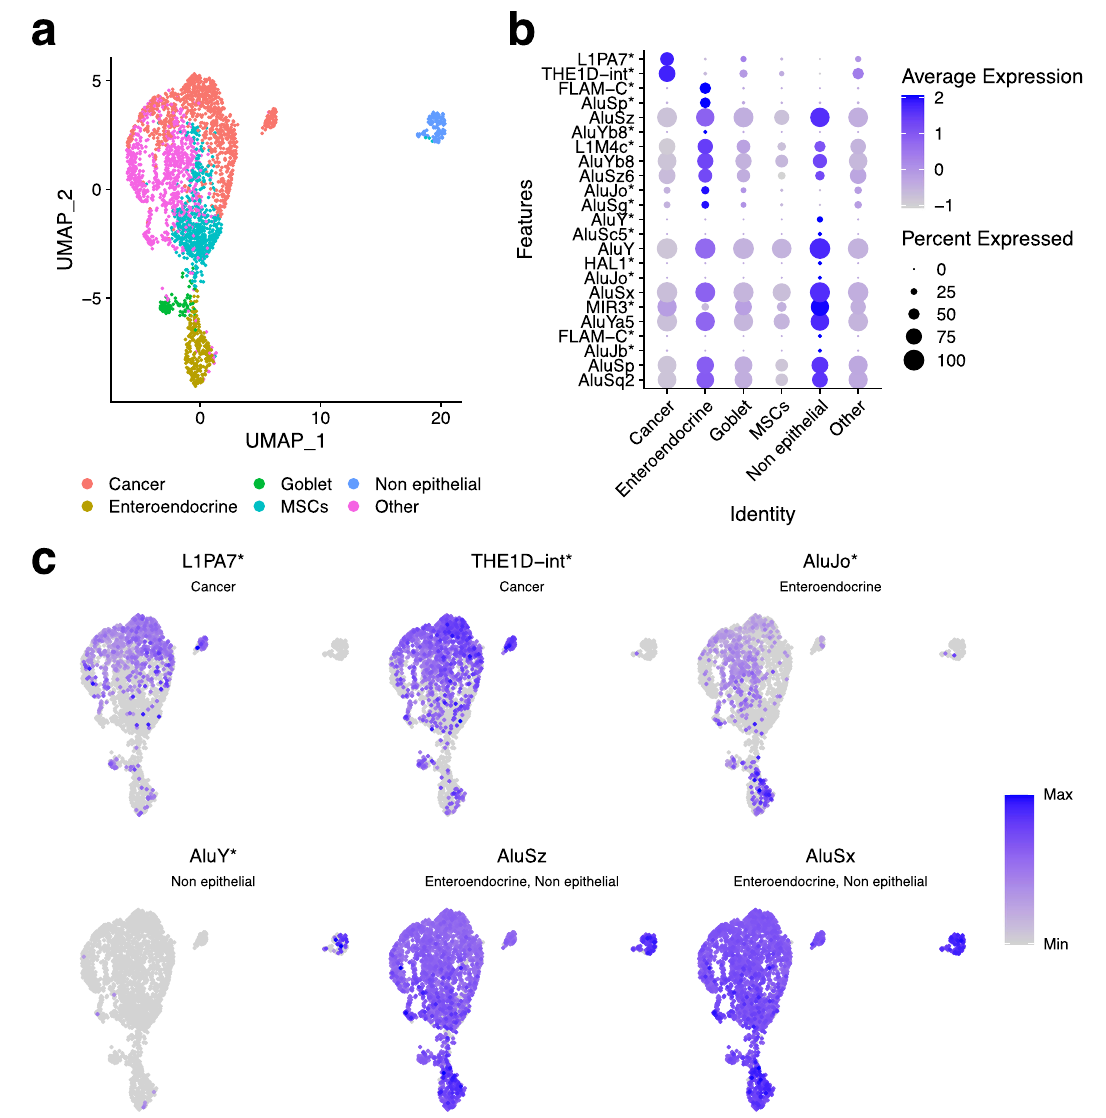
Fig. 5 TE expression detected with SoloTE during early gastric cancer. a UMAP plot indicating the different cell types. b Dot plot depicting marker TEs per cell types (indicated on the x axis). c UMAP plots of selected TEs. Label below the TE identi fi er indicates the cluster at which the TE is a marker. First two TEs are differentially expressed in the cancer cells, second two TEs in the enteroendocrine and non-epithelial cells, respectively, and the last two TEs are expressed across all cells, but show increased expression in the enteroendocrine and non-epithelial cells. “ * ” denotes locus-speci fi c